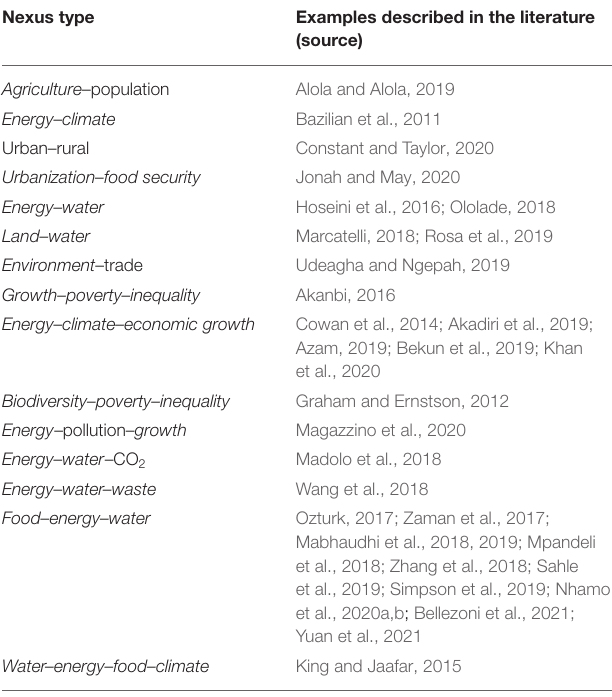
TABLE 1 | Examples of nexus studies in South